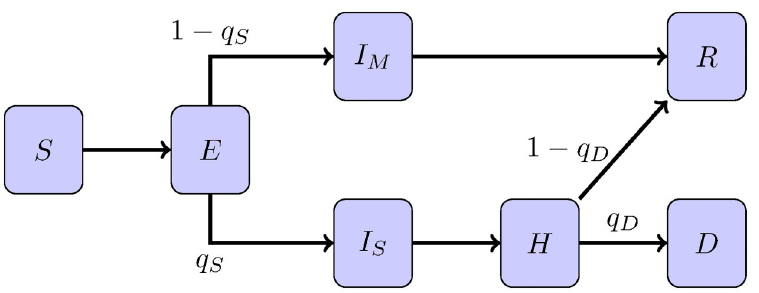
Fig 1. Diagram for the epidemiological classes in epiABM. Susceptible ( S ), Exposed ( E ), Mild infected ( I M ), Severe Infected ( I S ), Hospitalized ( H ), Recovered ( R ) and Deceased ( D